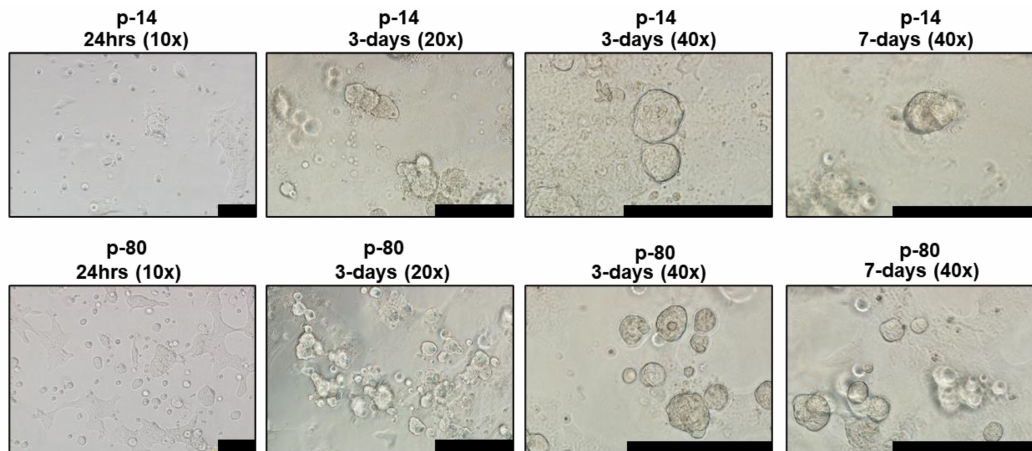
Figure 2. iSGEC-nSS2 early (p-14) and late (p-80) spheroid formation on matrigel. Legend. Cells were initially seeded at 4 × 10 4 per well. Cultures began to form spheroids at 24 h on matrigel (2 mg / mL). Early passages (e.g., p-14) formed larger, but overall fewer spheroids when assessed after 3 days. Spheroids appeared to reach their final size after 3–4 days. Scale bars represent 200 µ